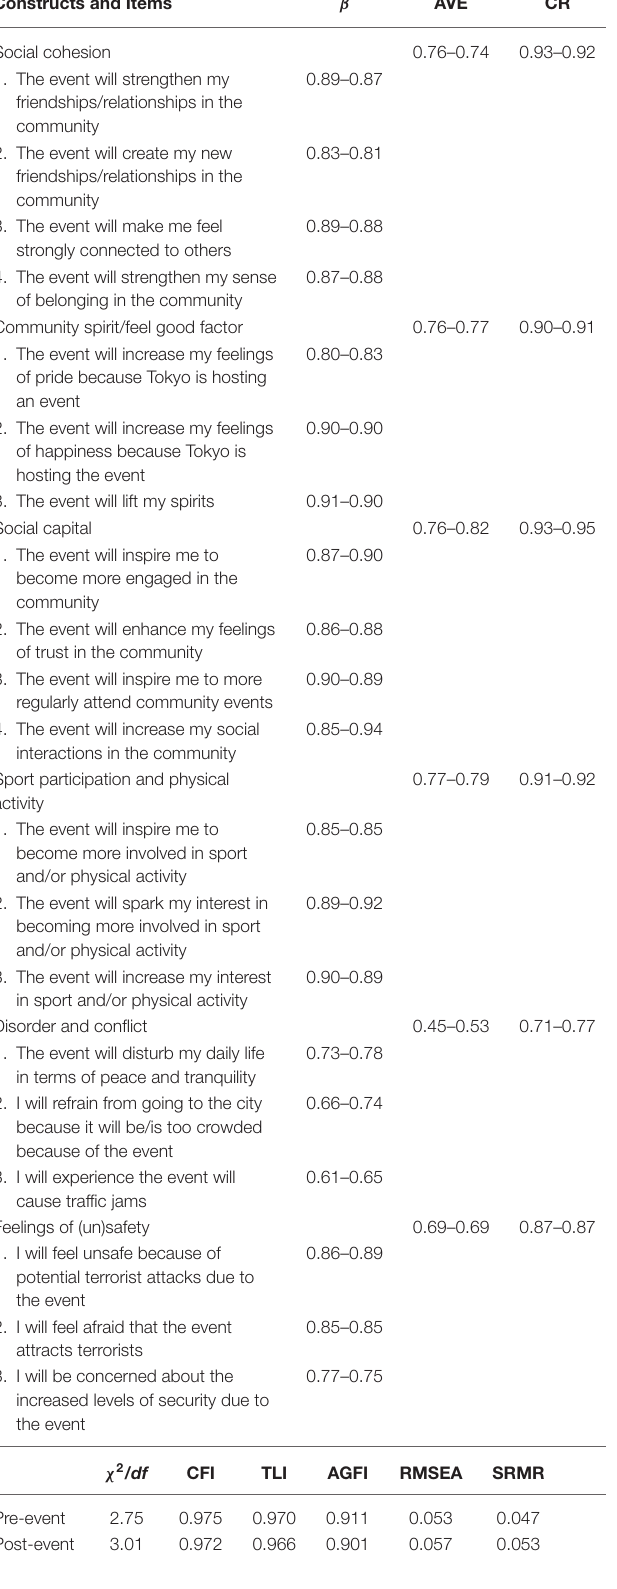
TABLE 2 | Descriptive statistics of each scale (pre-event in future tense presented here; post-event—in past tense). Constructs and Items